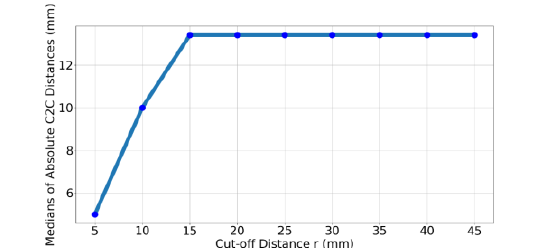
Figure 12. Median of absolute distances between SfM-based dense point cloud and TLS point cloud for each cut-off